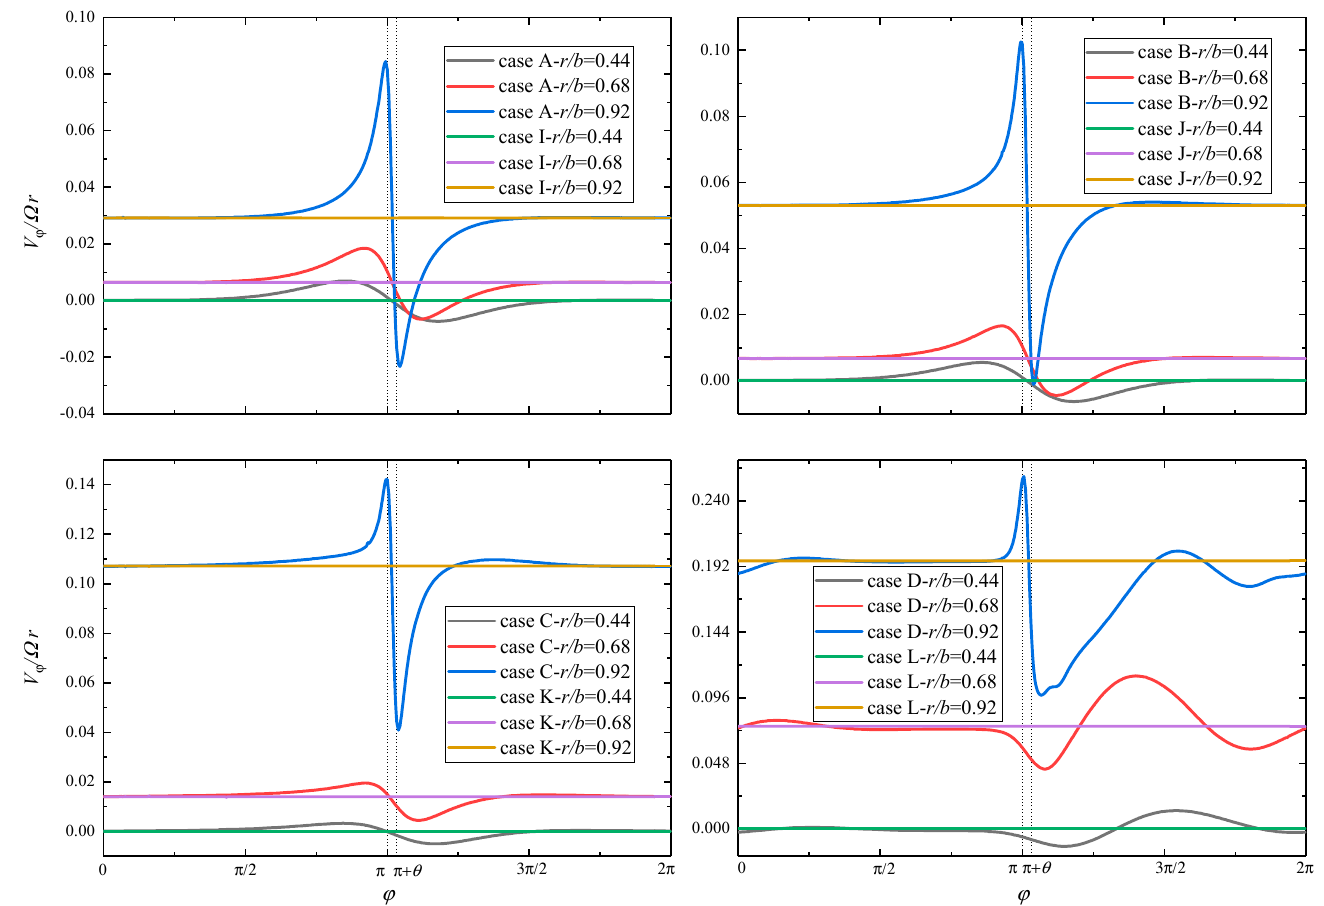
Figure 5. β curves with different radius at z/ s = 0.5.